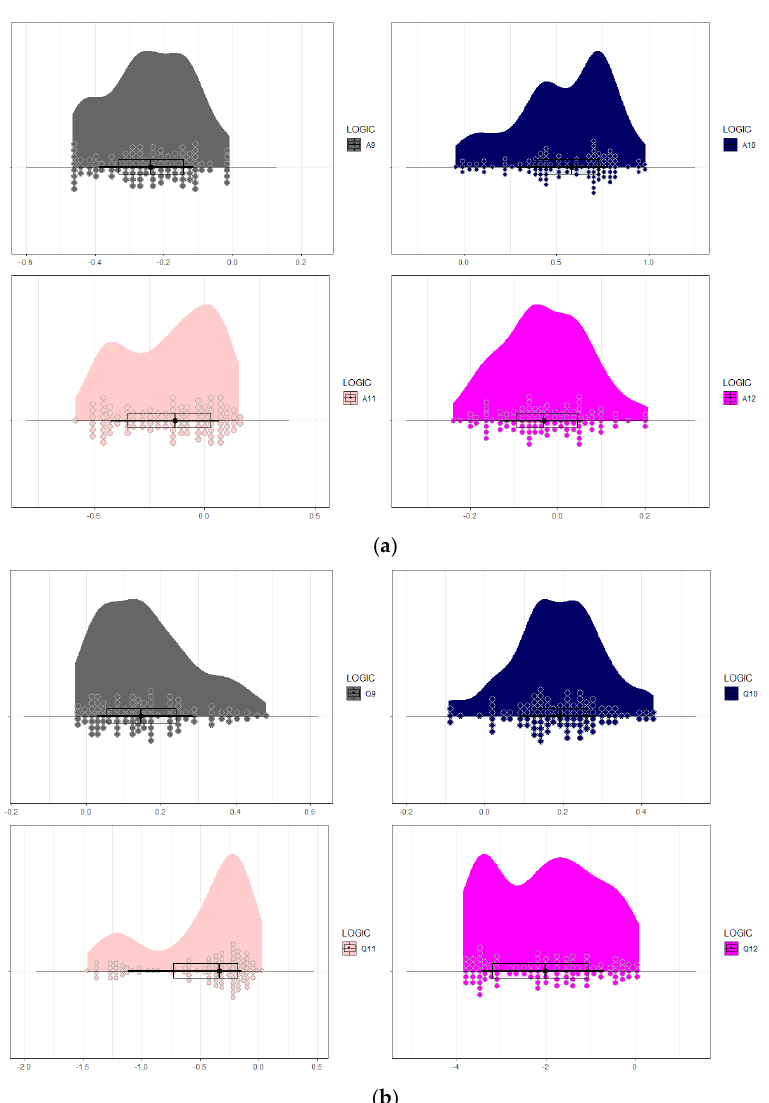
Figure 16. The Raincloud Plot analysis for ( a ) δ 1 2 SAT ρ , ( b ) δ 2 2 SAT ρ synaptic weight means when. When Y = 0.9 is observed from Figure 17 as